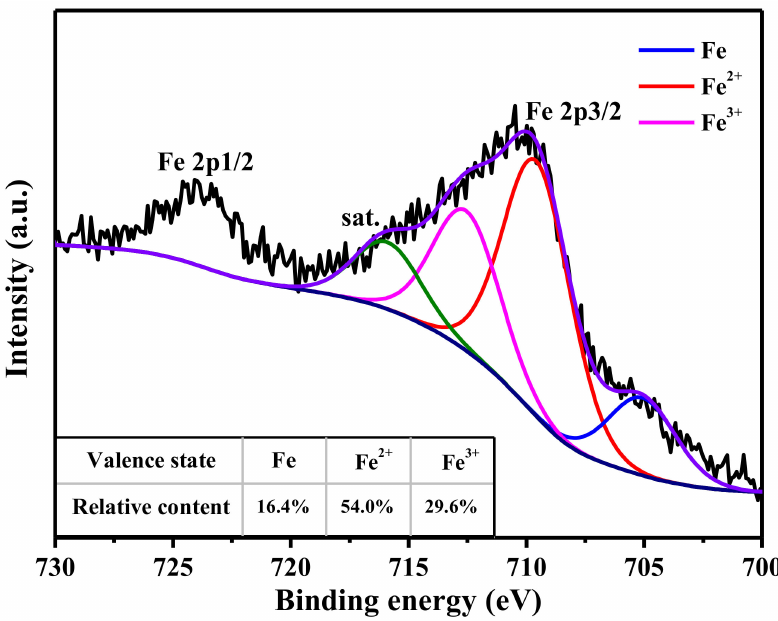
Figure 9. Fe2p spectra of fiber C 2 -2S; fiber C 2 -2S is defined in Section 2.4.